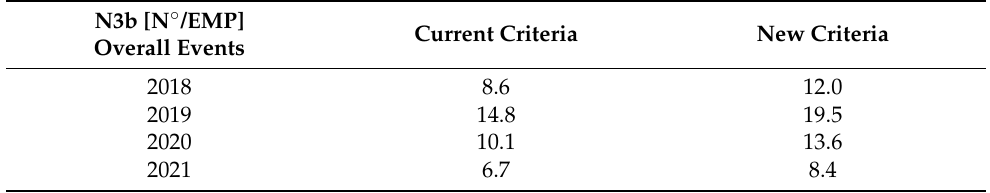
Table 13. N3b comparison: MV events.